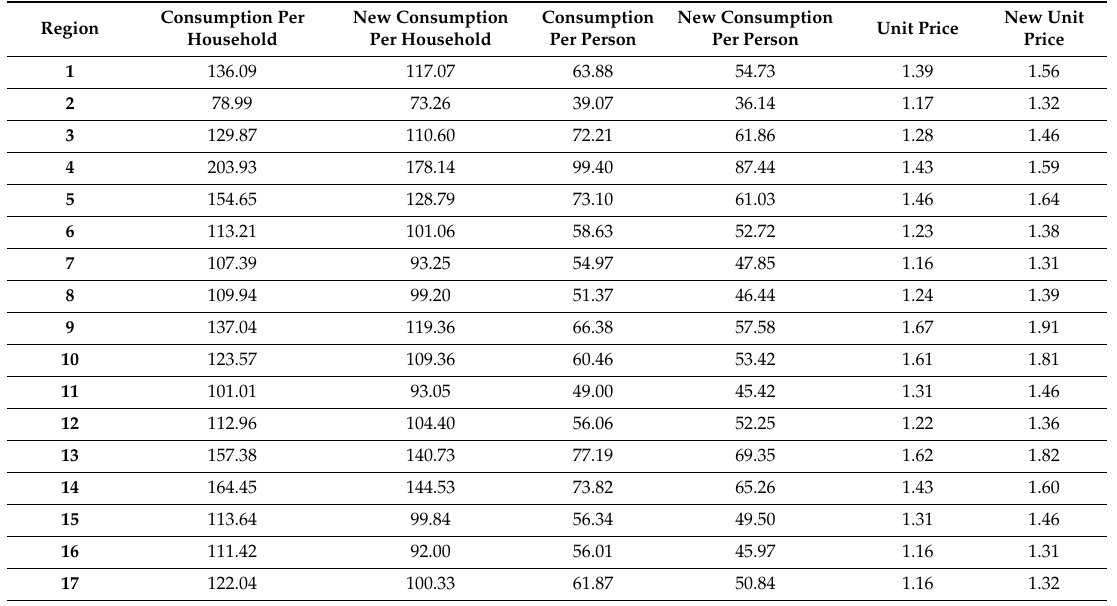
Table A1. Values before and after the Price Variation Introduced by Region.